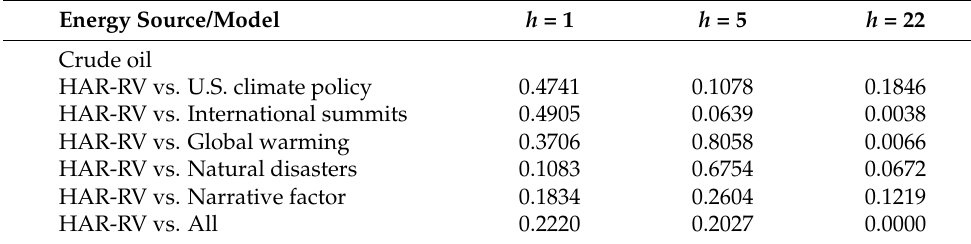
Table 2. Baseline test results. Results ( p -values; robust heteroskedasticity and autocorrelation consistent standard errors) of the Clark–West tests for an equal mean-squared prediction error are based on robust standard errors. The classic HAR-RV model is the benchmark model , and the model extended to include climate-risk factors is the rival model. The alternative hypothesis is that the rival model has a smaller MSPE than the benchmark model. The parameter h denotes the forecast horizon (in days). The models are estimated using a rolling-estimation window of length 250